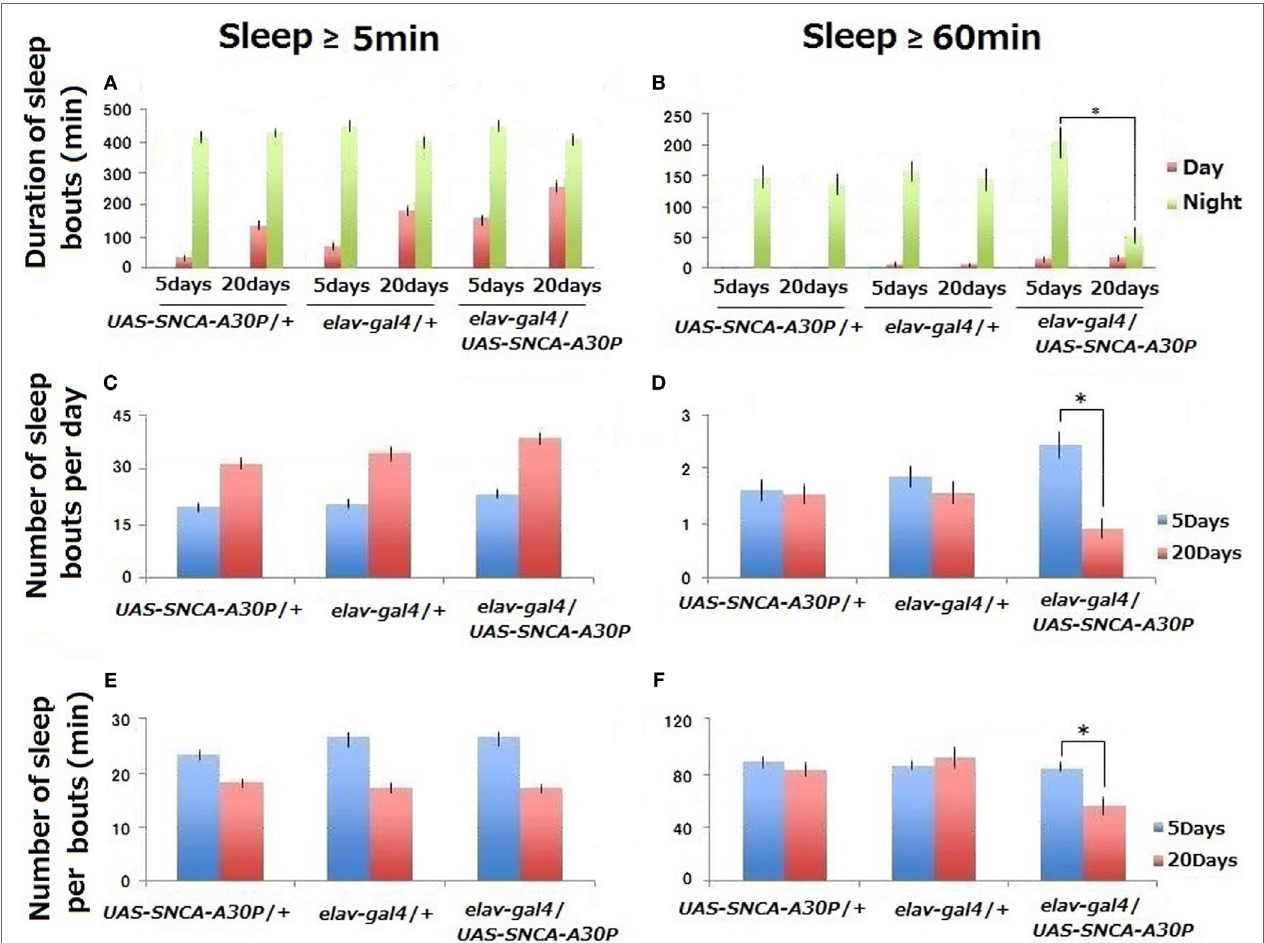
FigUre 1 | Sleep behaviors of controls ( UAS-SNCA-A30P/ + and elav-gal4/ + ) and A30P Parkinson’s disease model ( elav-gal4/SNCA-A30P ) Drosophila males during 3 days. Comparison was done from 3 to 5 days and from 18 to 20 days after eclosion ( n ≥ 24). Sleep amount/day (a,B) , number (c,D) , and duration (e,F) of sleep bouts. Statistical data by Student’s t -test are expressed as mean ± SEM. We have repeated this experiment for five times. * represents significant differences ( p <